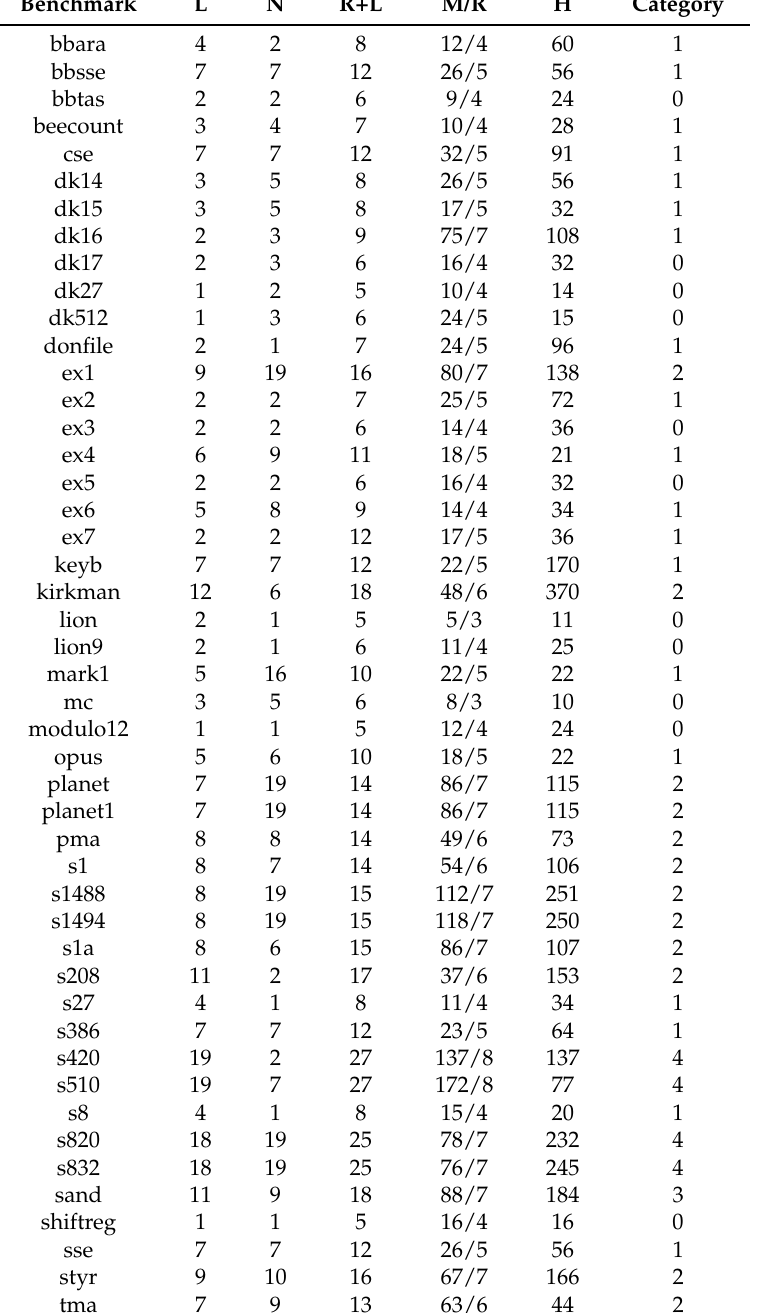
Table 4. Characteristics of Mealy FSM